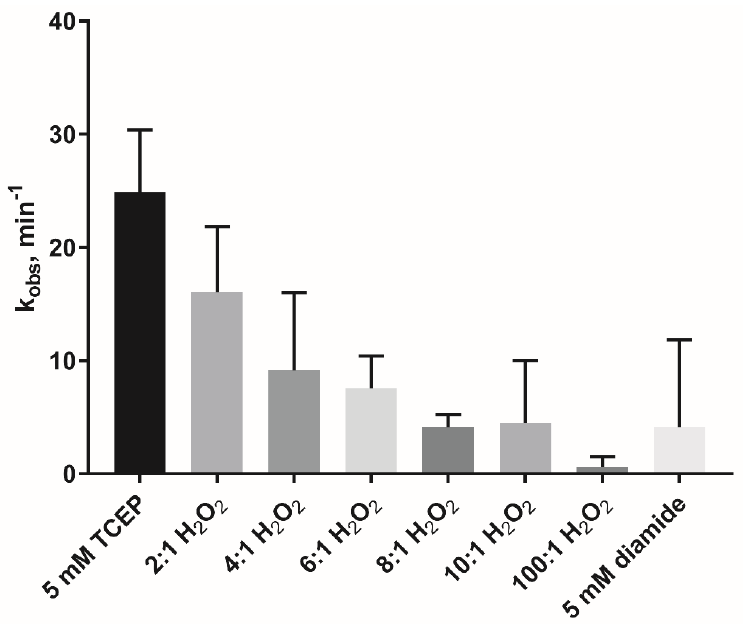
Figure 3. Glyoxalase activity of AtDJ-1B is lost after oxidation. Reduced and oxidized AtDJ-1B